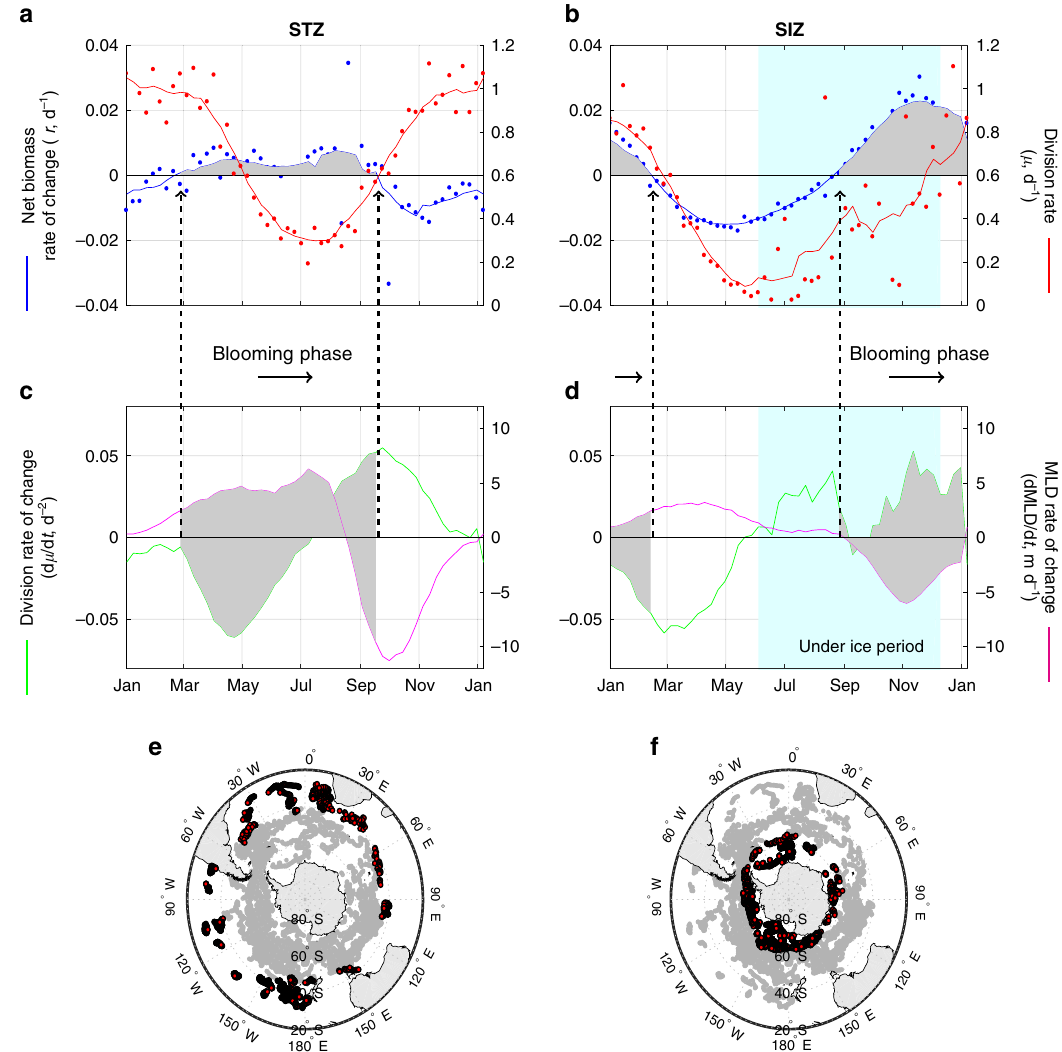
Fig. 3 Climatological bloom cycles in the Subtropical and Seasonal Ice Zone (STZ and SIZ). a , b The annual cycle of net phytoplankton biomass rate of change ( r , blue line) and division rates ( μ , red line) for the STZ and SIZ. Individual points are weekly averaged observations and the continuous line is the result of a smoothing temporal fi lter (Methods). c , d Averaged time series of the temporal derivative of μ (d μ /dt, green line) and of the mixed layer depth (MLD) (dMLD/dt, magenta line). The blooming phase ( r > 0) is highlighted by the gray shaded periods. The light blue shaded section indicates the period where 50% or more pro fi les were under ice. e , f Bottom maps: Location of fl oat pro fi les in the STZ